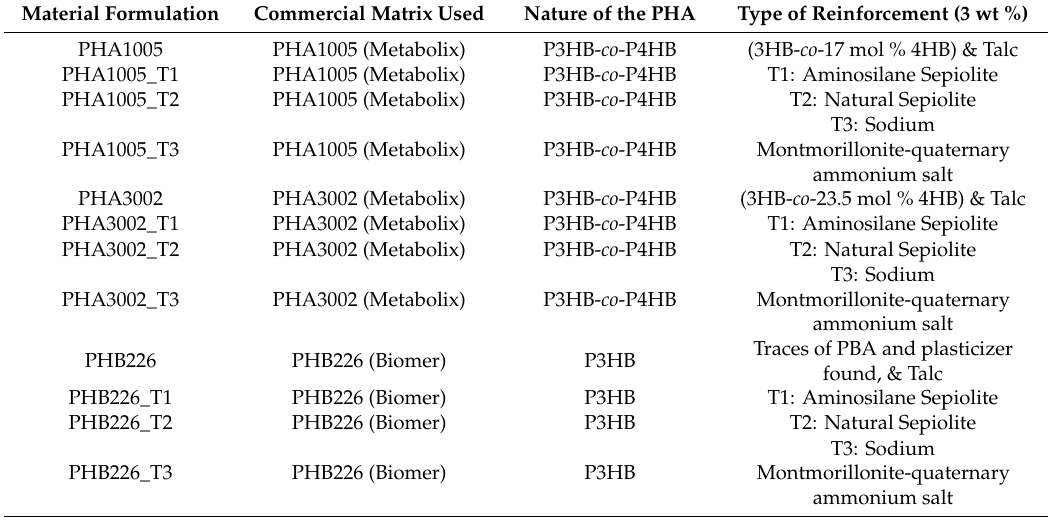
Table 1. Summary of material formulations. Table reproduced with permission of Garc í a-Quiles et al. [30]. Material